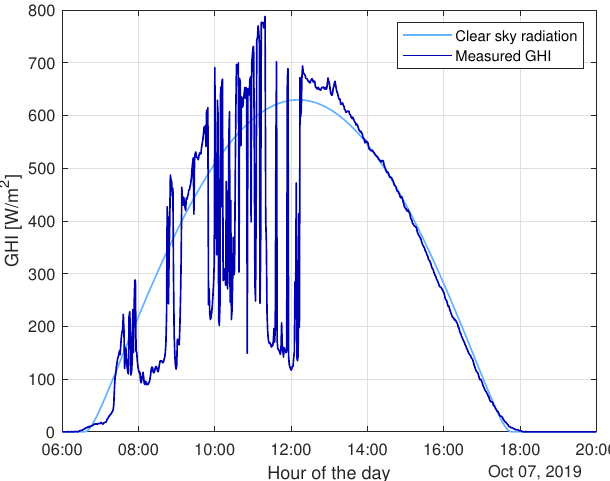
Figure 2. Measured GHI and clear-sky radiation on a variable weather